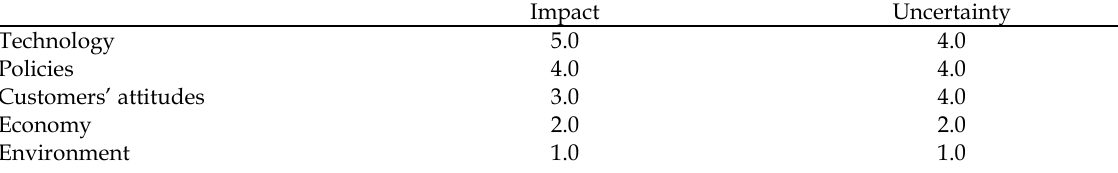
Table 2. The median value of driving forces rank according to their impact and uncertainty (1- lowest, 5-highest). Results from five experts’ responses collected in Delft University of Technology workshops.